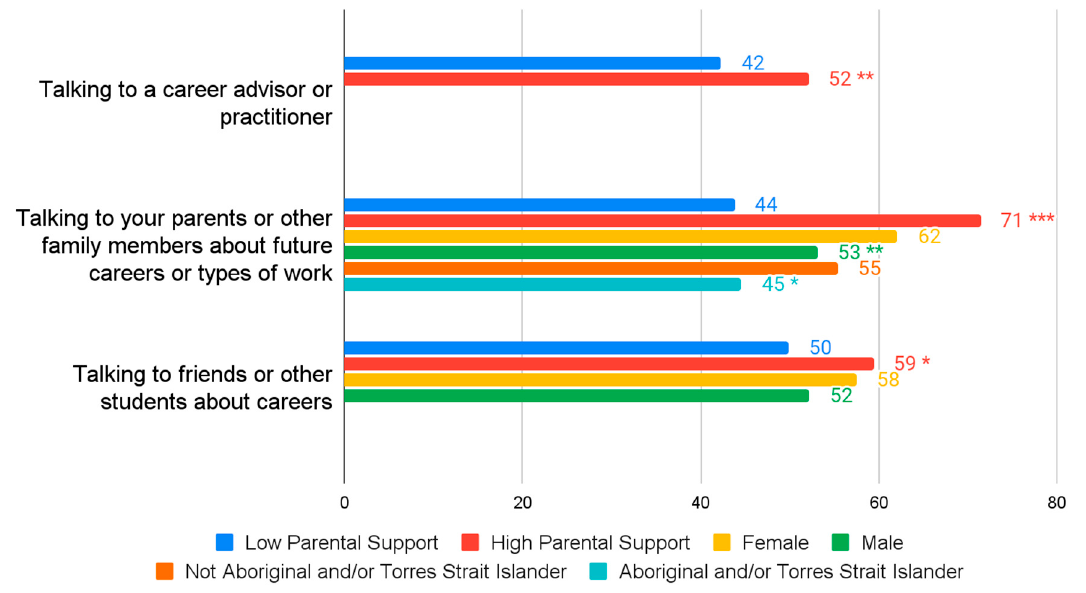
Figure 3. Which of the following activities have you ever done to help make decisions about your future career? (Data source: Survey. n = 1108. * p < 0.05; ** p < 0.01; *** p < 0.001). Parental support was a consistent predictor of careers advice-seeking across all three activity types. Those receiving a high level of support are significantly likelier to report ‘talking to a career advisor or practitioner’ than those with low parental support (52% vs. 42%; p = 0.009), somewhat reflecting the research literature that shows that young people from low-SES backgrounds are less likely to engage with services [9,48].